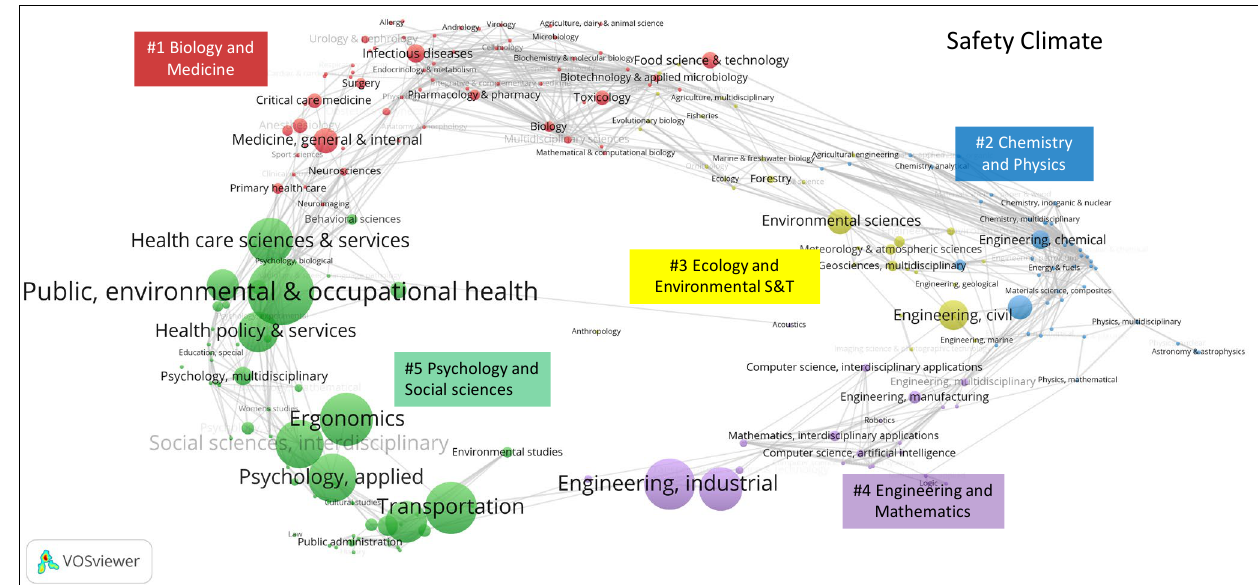
Figure 6. Location of Web of Science categories for safety climate publications in the global science overlay map (generated using the Loet Leydesdorff disciplinary overlay toolkit and visualized using VOSviewer; see Section 2.2 for references).